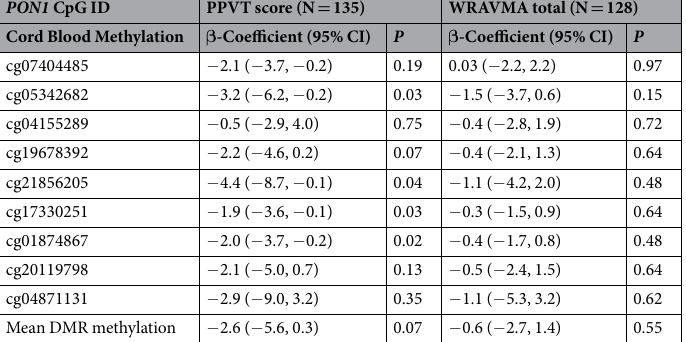
Table 4. Adjusted associations for methylation levels of the 9-CpGs in the DMR of the PON1 gene in cord- blood of males with cognitive test scores measured during early childhood. Estimated change in cognitive